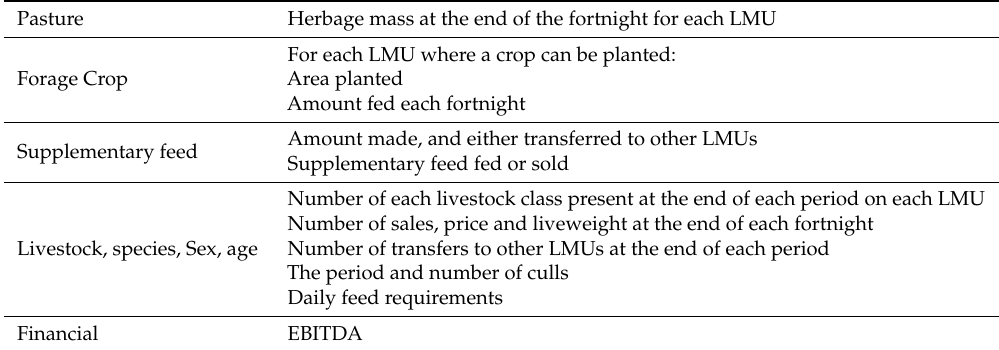
Table 2. Outputs from AgInform ® .